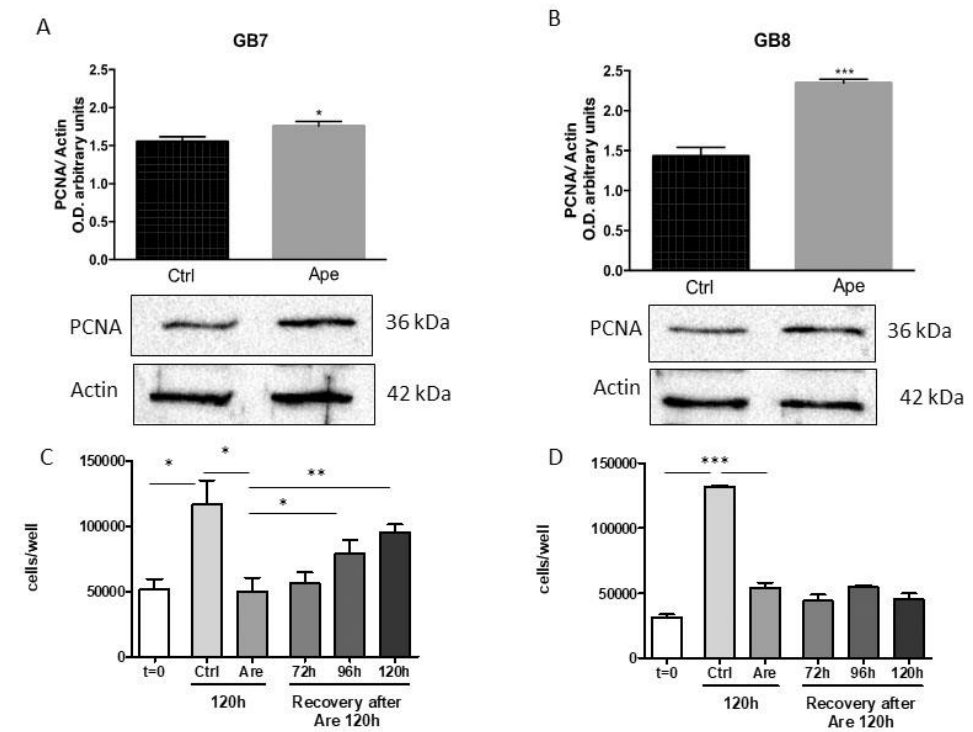
Figure 5. Western blot analysis for PCNA expression in GB7 ( A ) and GB8 ( B ) cells in absence (ctrl) and presence of 100 µ M APE (48 h). The diagrams above report the densitometric analysis of the PCNA immunoreactive bands normalized to those of the β -actin reference. The data are the average ± SEM of three independent experiments (t-test; * p < 0.05; *** p < 0.01). ( C ) and ( D ) Recovery of cell proliferation after APE withdrawal. The cells were maintained for 120 h in the presence of APE 100 µ M. Then the APE was removed from the culture media and substituted by fresh medium without APE for an additional 72, 96 and 120 h. Results are reported for GB7 ( C ) and GB8 ( D ) cells. (t-test; * p < 0.05; ** p < 0.01; *** p < 0.001).